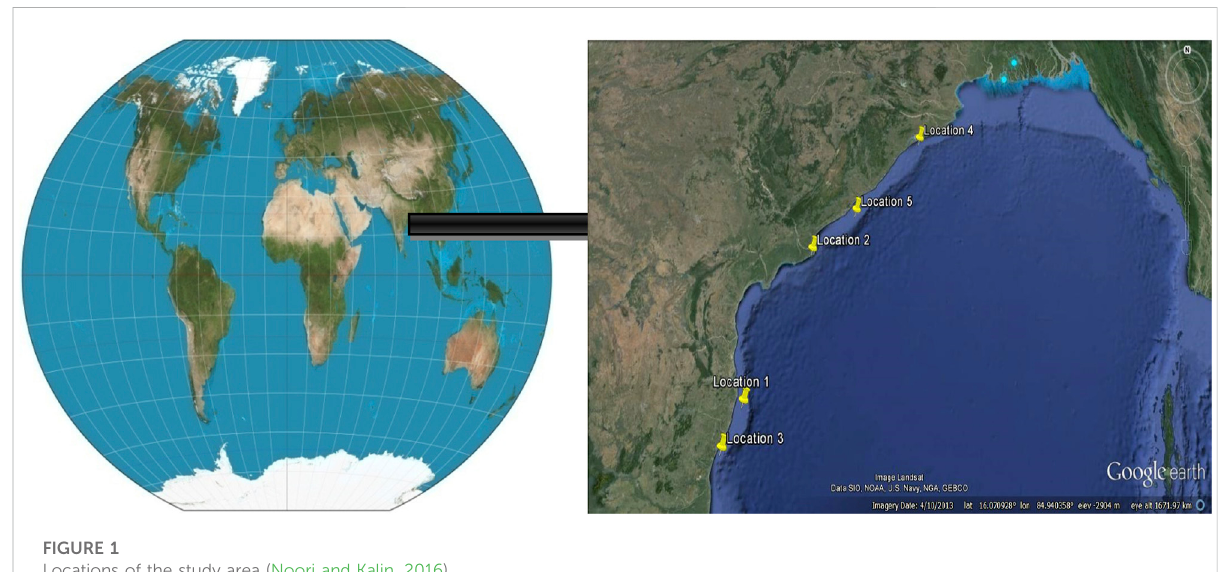
FIGURE 1 Locations of the study area (Noori and Kalin,